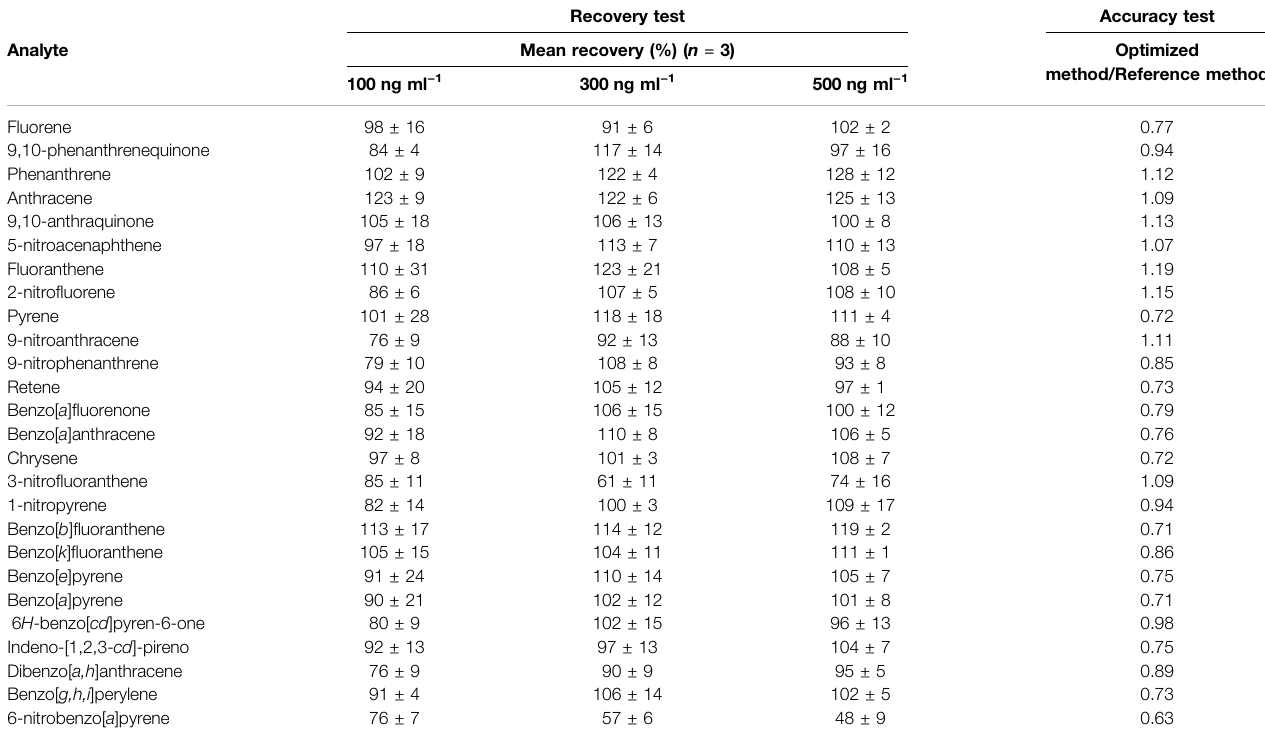
TABLE 4 | Mean recoveries of the analytes determined (in triplicate) in spiked PM 10 samples, at three different concentrations. Accuracy test is also presented and it was evaluated by the ratios of the signals obtained using the optimized method here proposed and the reference method according to Alves et al., 2011. Recovery